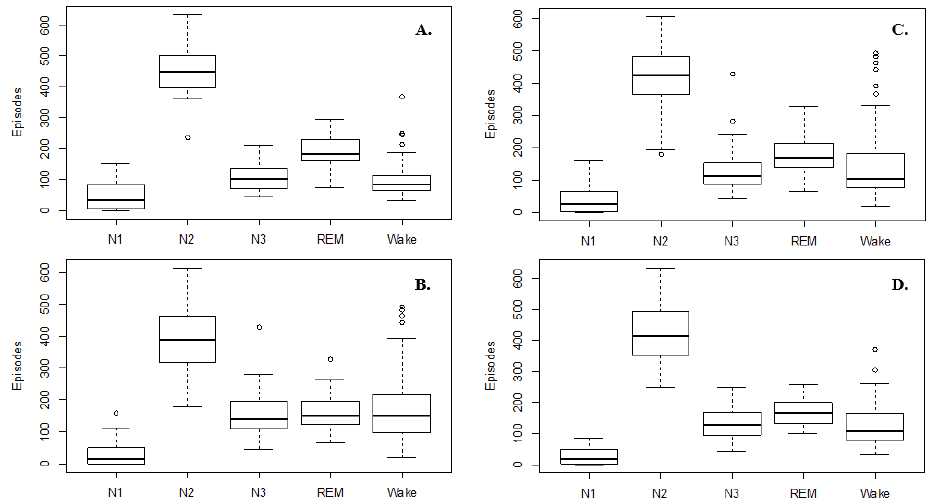
Figure 2. Distribution of sleep structure for ( A ) control group, ( B ) OSA group, ( C ) training set, and ( D ) test set, ° is represented outliers.